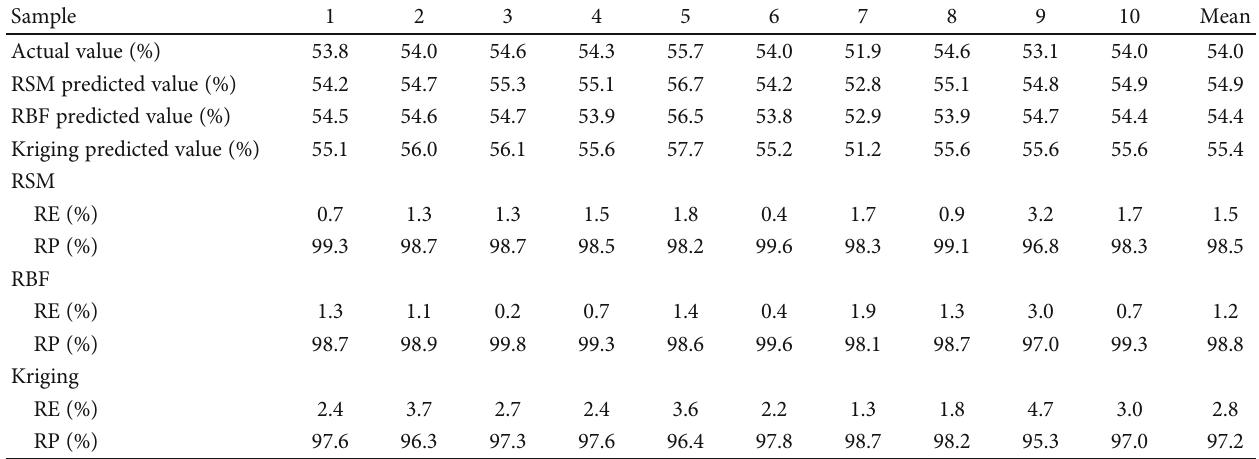
Table 2: The actual value, predicted value, RE, and RP of hollowed core ratio of the three models. Sample